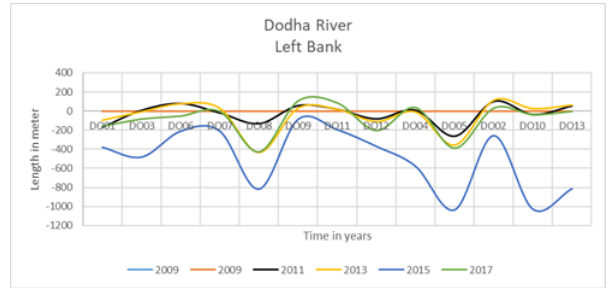
Fig 9: Variation in shifting of left bank of Dodha River inwards and outwards taken 0 as the